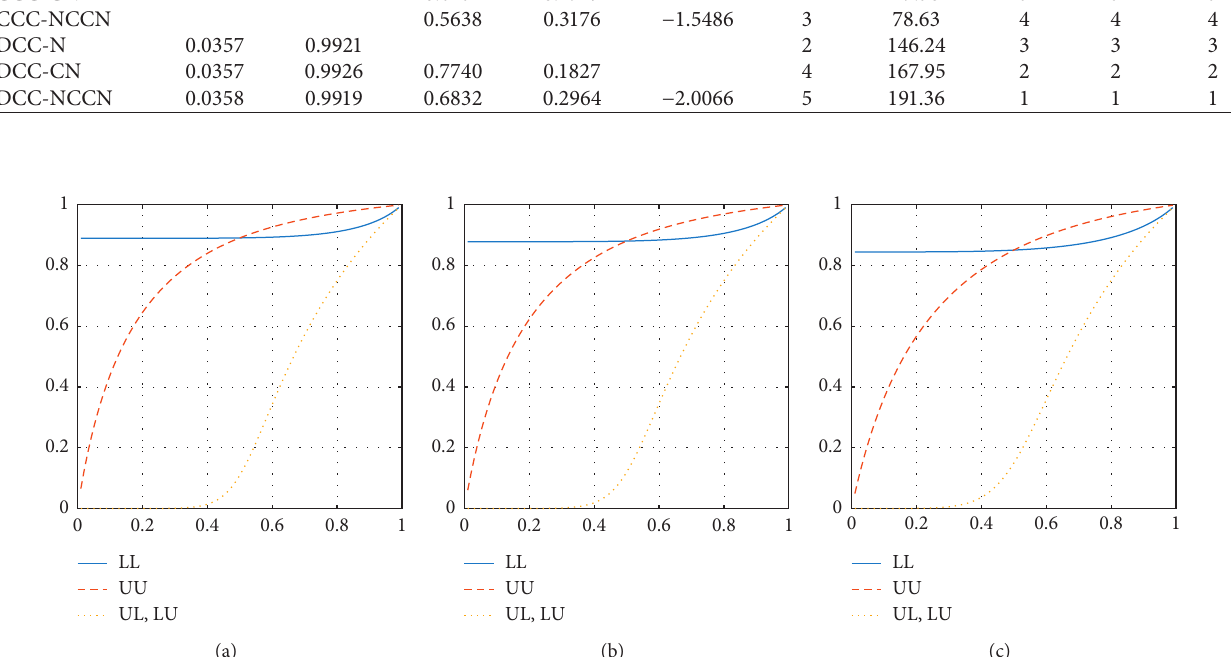
Figure 10: QD curves of bivariate Clayton copula model. (a) HSI-CEI. (b) HSI-CCI. (c) CEI-CCI.